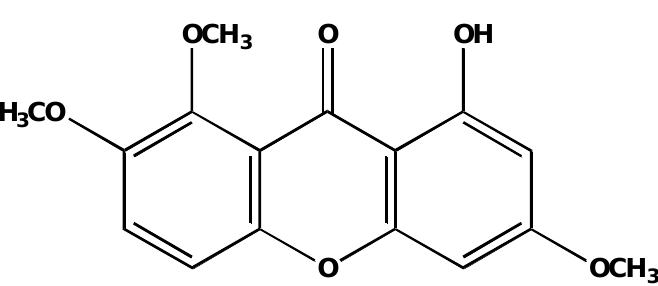
Figure 1. Structure of